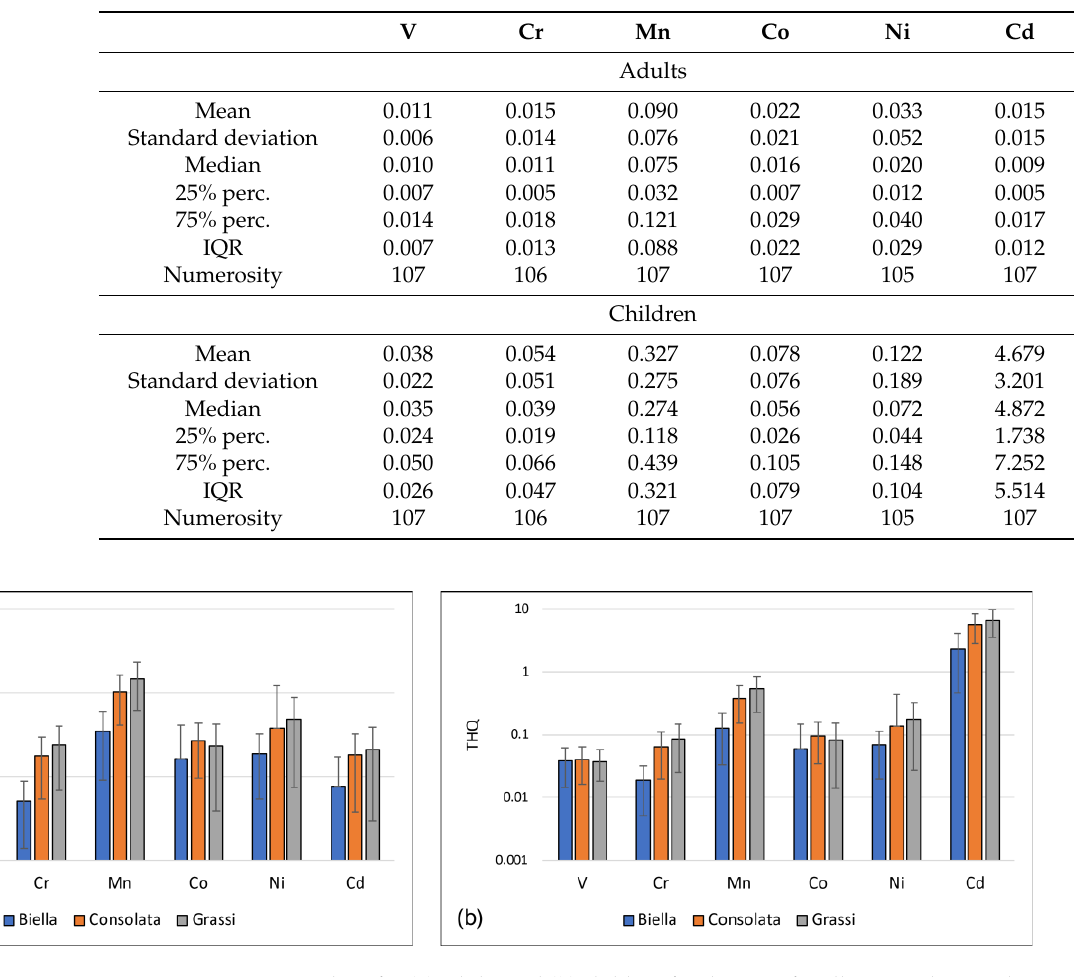
Figure 8. THQ mean values for ( a ) adults and ( b ) children for the site of Biella, Consolata, and Grassi. The length of the bars corresponds to the standard deviation of the data and represents the dispersion of the values.